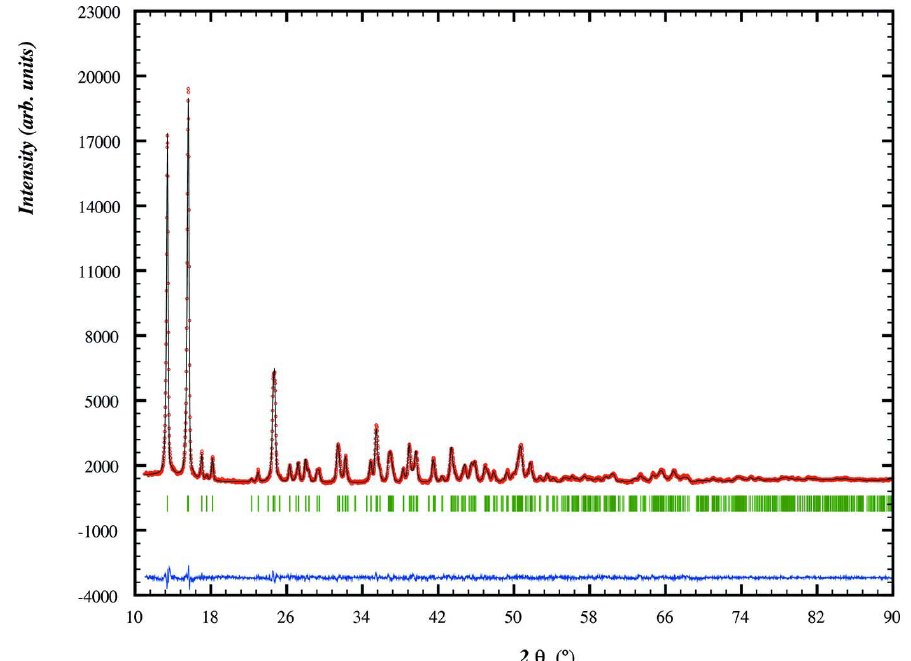
The Rietveld plot for (I), showing the observed (red circles), calculated (black line) and difference (blue line) patterns. The reflection positions are shown as vertical bars above the difference